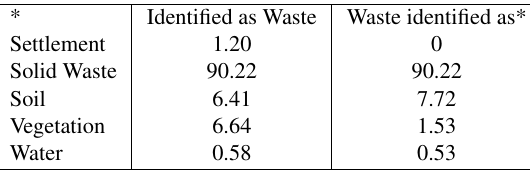
Table 1: Statistics of solid waste detection in percentage.